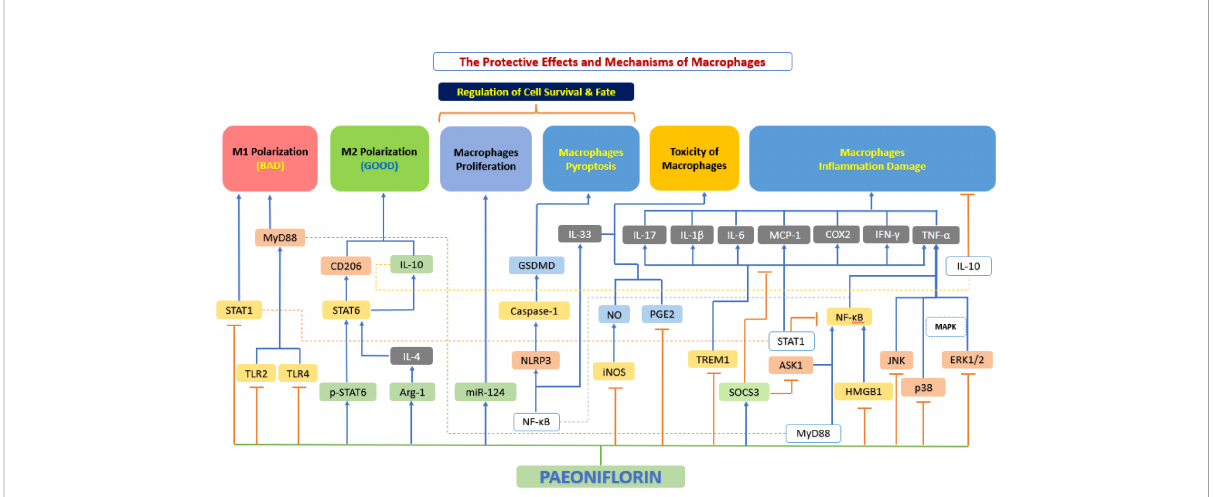
FIGURE 8 The protective effects and mechanisms of paeoni fl orin on macrophages. Paeoni fl orin has a protective effect on macrophages, which is achieved by regulating the phenotypic transformation of macrophages, inhibiting macrophage in fl ammatory factor secretion, regulating macrophage survival and fate, inhibiting macrophage proliferation and blocking foam cell formation. Arg-1, arginase 1; ASK1, apoptosis signal-regulating kinase 1; COX2, cyclooxygenase-2; ERK1/2, extracellular signal-regulated kinase 1/2; GSDMD, gasdermin D; HMGB1, high mobility group box 1; IFN- g , interferon- g ; IL-10, interleukin 10; IL-10, interleukin 10; IL-1 b , interleukin 1 b ; IL-33, interleukin 33; IL-4, interleukin 4; IL-6, interleukin 6; iNOS, inducible nitric oxide synthase; JNK, c-Jun N-terminal kinase; MAPK, mitogen-activated protein kinase; MCP-1, monocyte chemoattractant protein-1; miR-124, microRNA-124; MyD88, myeloid differentiation primary response 88; NF- k B, the nuclear factor-kB; NLRP3, NOD-like receptor 3; NO, nitrous oxide; p38, p38 mitogen-activated protein kinase (MAPK); PGE2, prostaglandin E2; p-STAT6, phosphorylation signal transducer and activator of transcription 6; SOCS3, suppressor of cytokine signaling 3; STAT1, signal transducer and activator of transcription 1; STAT1, signal transducer and activator of transcription 1; STAT6, signal transducer and activator of transcription 6; TLR2, toll-like receptor 2; TLR4: toll-like receptor 4; TNF- a , tumor necrosis factor a ; TREM1, triggering receptor expressed on myeloid